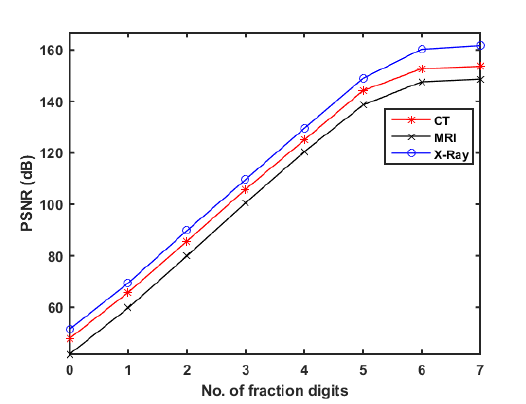
Figure 7. PSNR vs Number of the fraction digits for the proposed LNS-DWT.